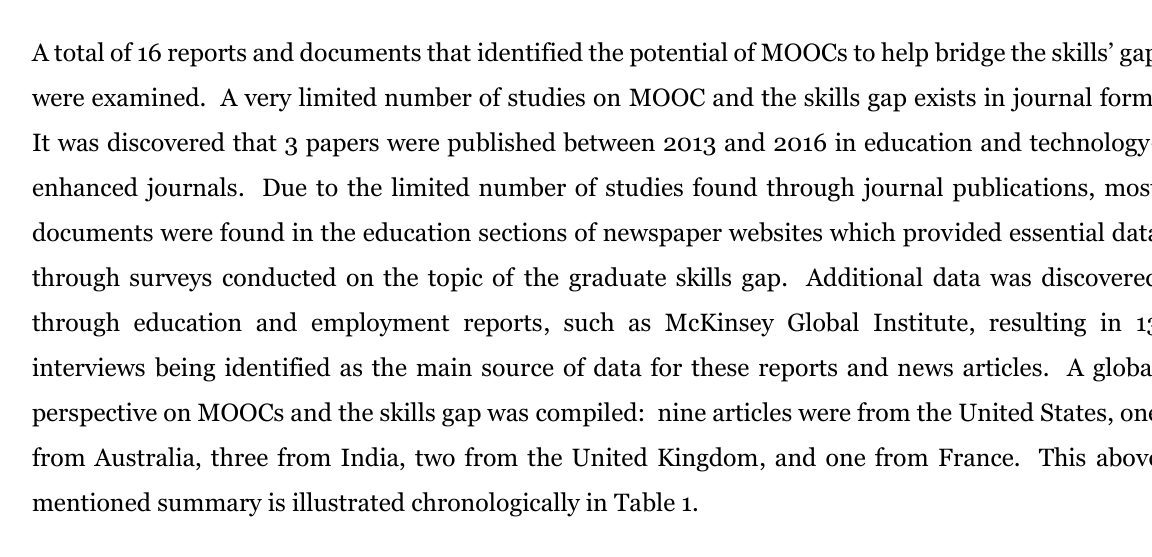
MOOCs and Skills Year Location Author Source/Article